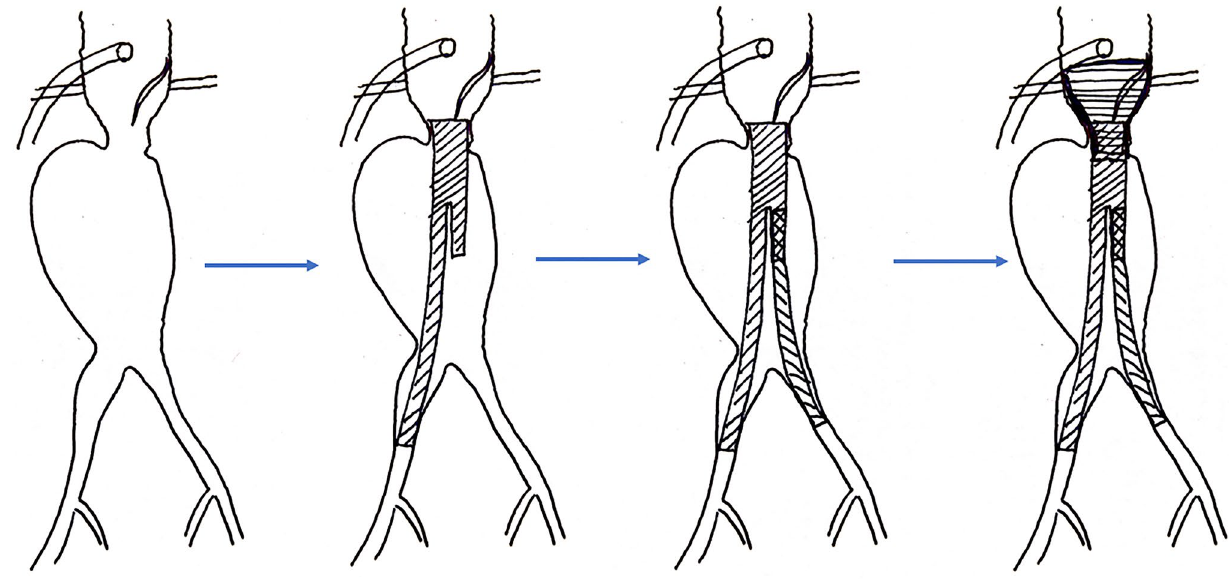
Fig. 4 Schematic diagram of EVAR procedure